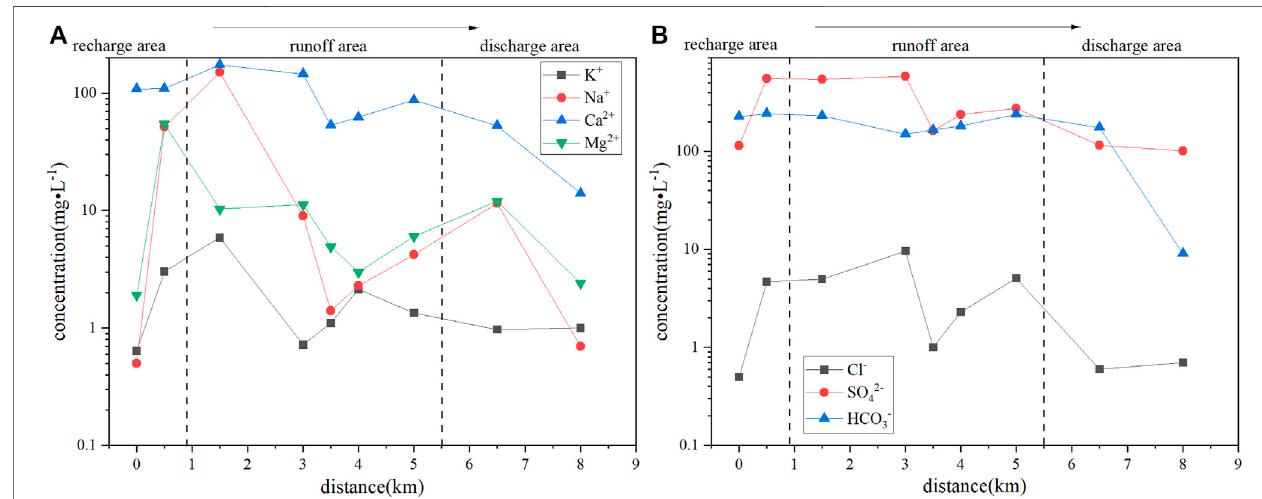
FIGURE 3 | (A) spatial distribution of Sb; (B) Sb cumulative